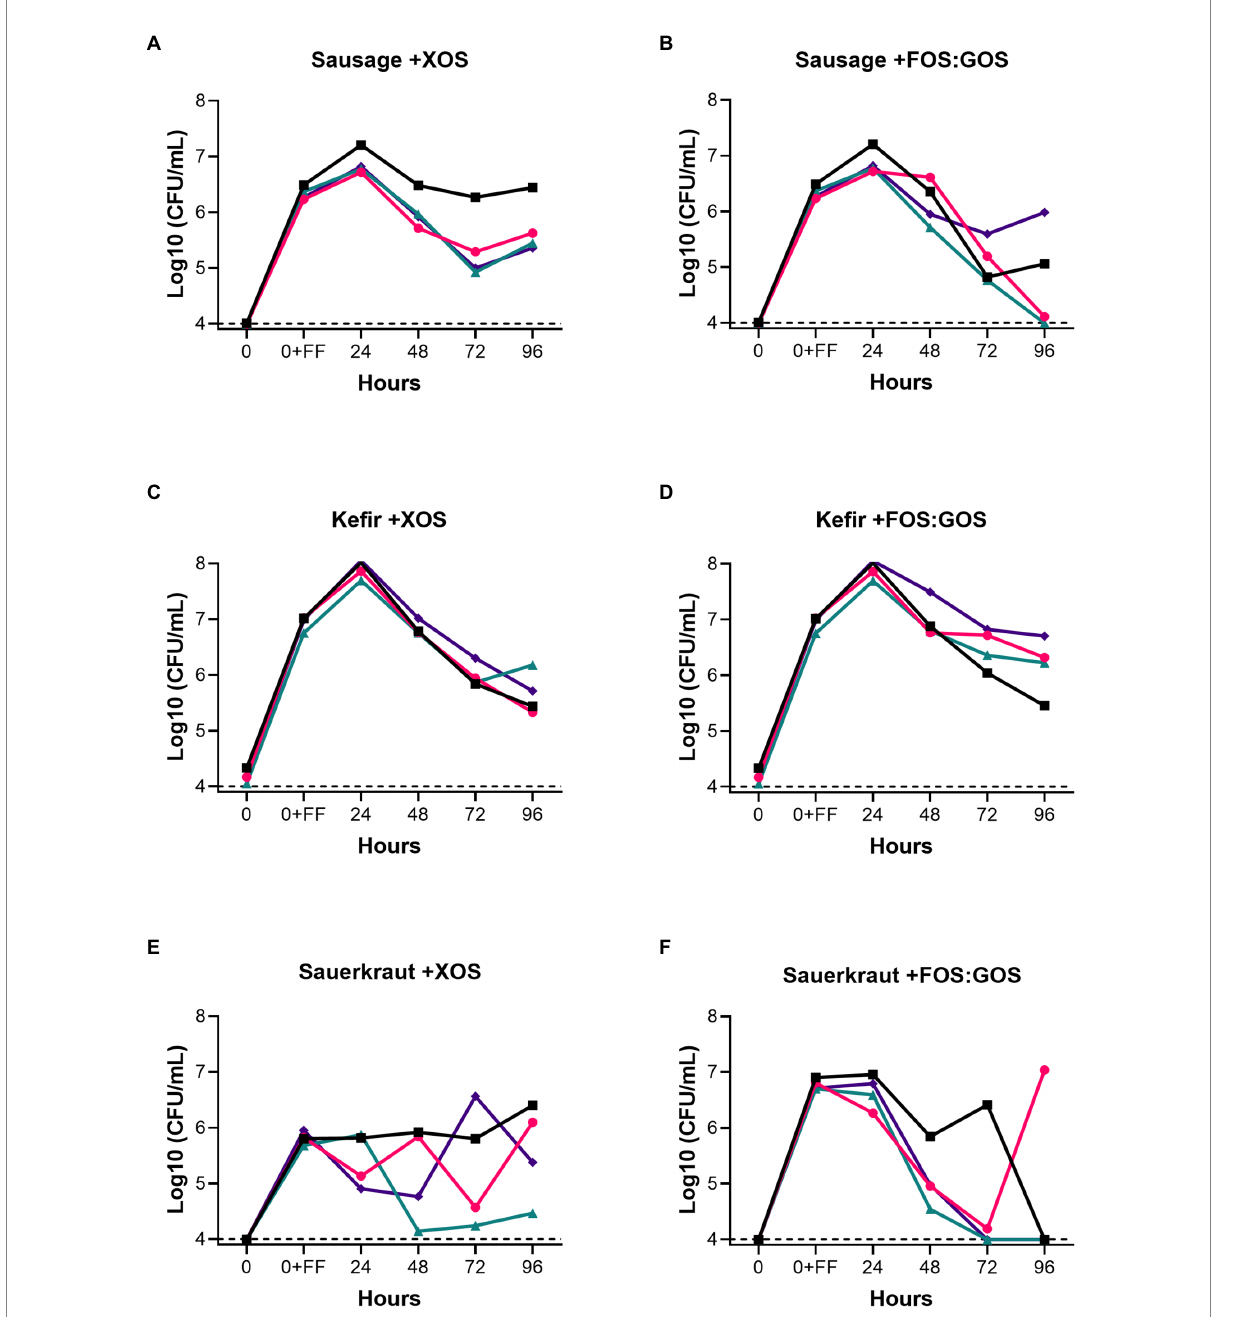
FIGURE 3 Prebiotics enhance the persistence of fermented food-associated Lactobacillaceae. The persistence of Lactobacillaceae from sausage (A,B) , kefir (C,D) or sauerkraut brine (E,F) were monitored over time (0–96 h) in simulated gastrointestinal environments colonized with one of four fecal samples in GSM supplemented with 1% XOS (A,C,E) or GSM supplemented with a mixture of 0.5% FOS: 0.5% GOS (B,D,F) . Samples were collected at the time points indicated. Baseline indicates the limits of detection (10 4 CFU/mL). Each colored line indicates a unique fecal microbiota (Fecal 1, black squares; Fecal 2, pink circles; Fecal 3, teal triangles; Fecal 4, purple